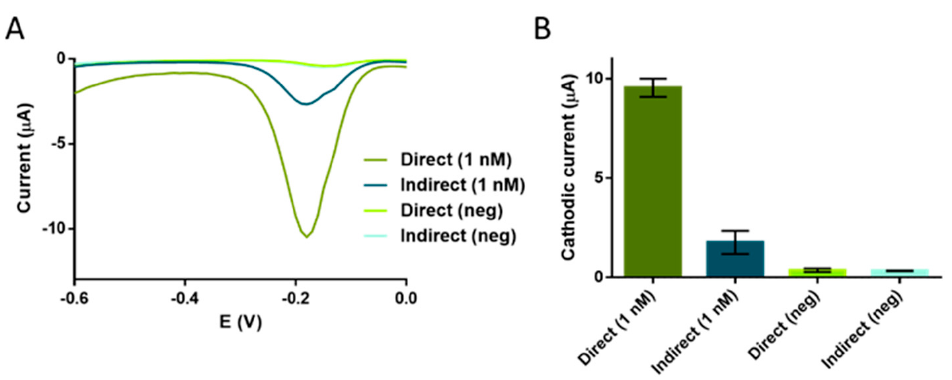
Figure 6. Comparative study on direct and indirect readout systems for the rolling circle amplification and electrochemical genosensing. For both systems, 1 nM of circularized bacterial DNA were used, except for the negative controls. ( A ) Raw square wave voltammetry data. ( B ) Graph bars of the SWV maximal signal. The bars represent the mean value of the maximal signal and the error bars, the standard deviation for n = 3. Medium: phosphate buffer. Mediator: hydroquinone 1 mmol L − 1 . Substrate: H 2 O 2 0.25 mmol L − 1 . The potential range was 0.1 to − 0.7 V with potential step and amplitude of 10 mV and frequency of 1 Hz. For both systems, the negative control without the DNA template, were performed (n = 3).